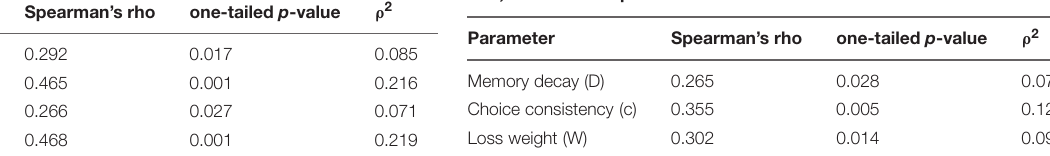
TABLE 8 | Correlations for parameters estimated from the IGT and SGT of the model with expectancy utility function, decay-reinforcement learning rule, and trial-independent choice